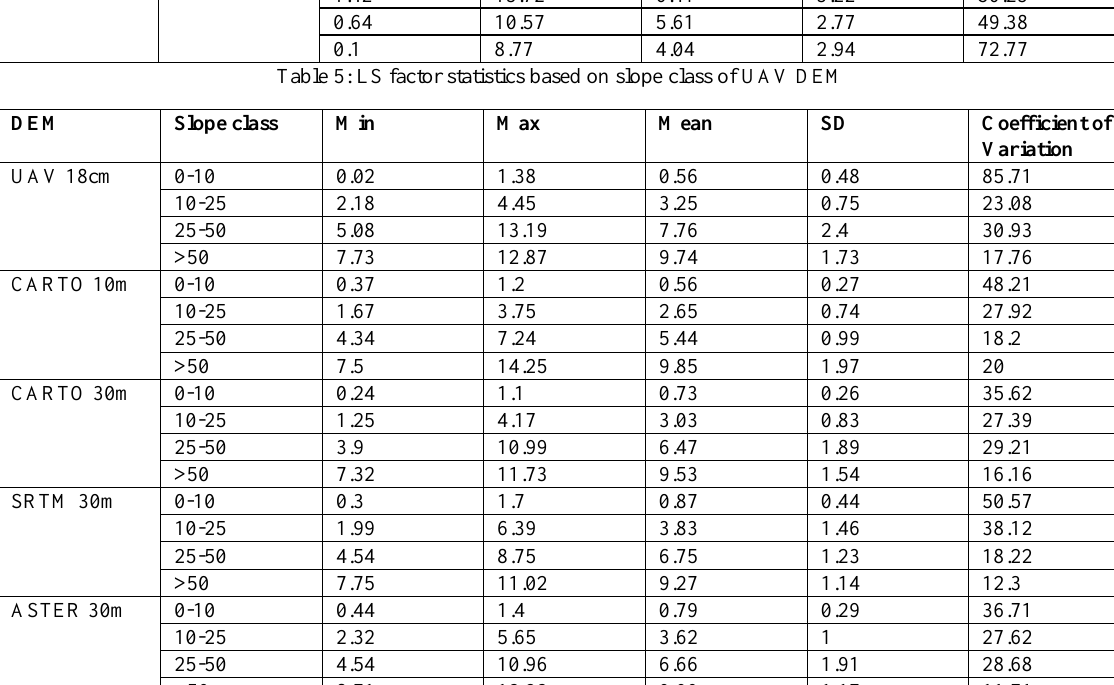
Table 6: LS factor statistics based on slope class of respective